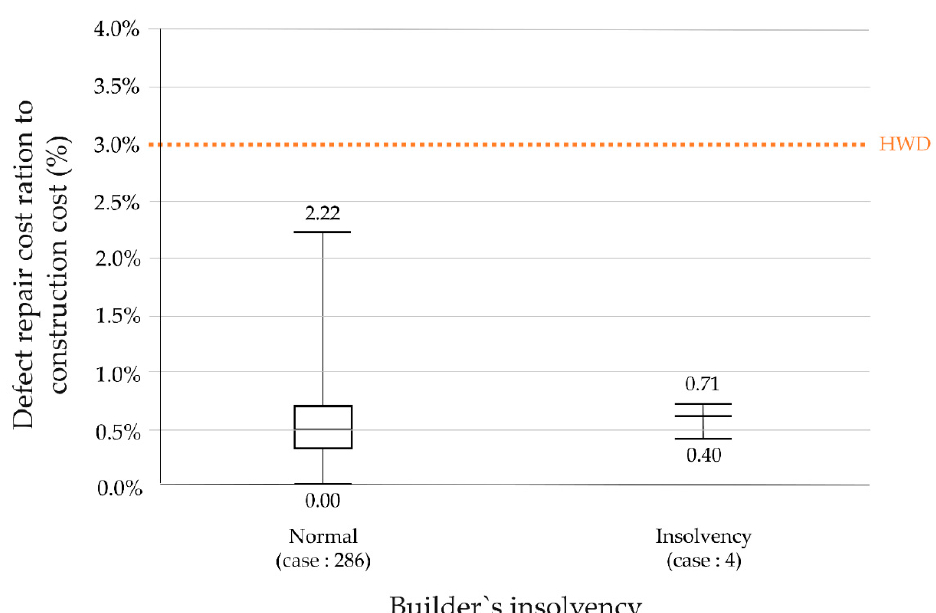
Figure 10. Comparison of developer’s insolvency.